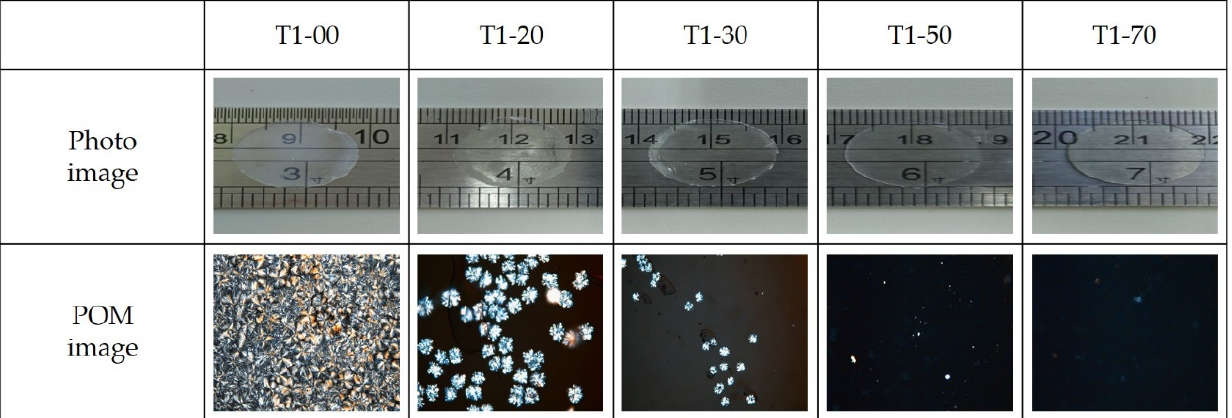
Figure 2. Photo and POM images of T1 series SPE membranes.